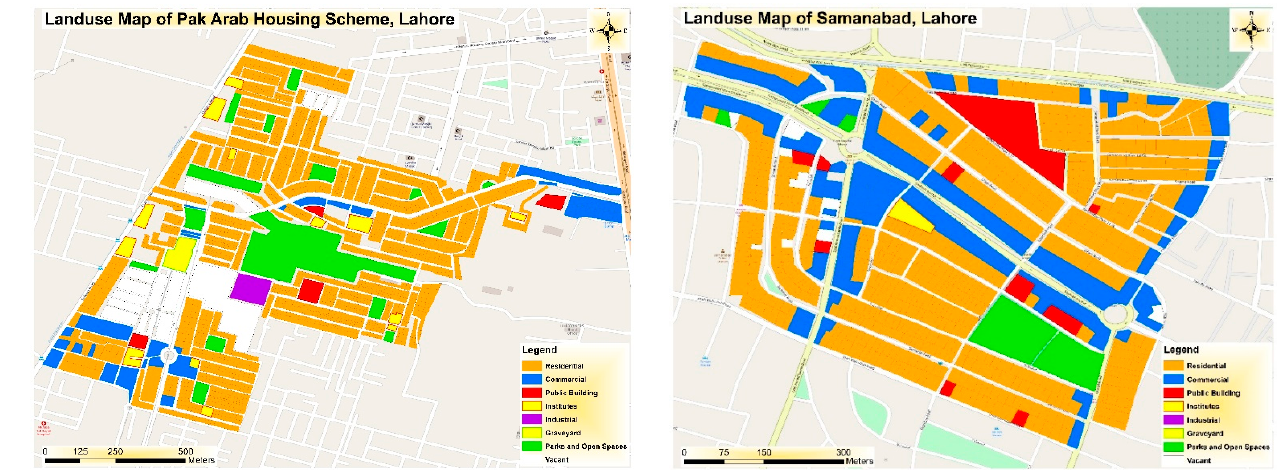
Figure 2. The two selected neighborhoods in Lahore, [42].